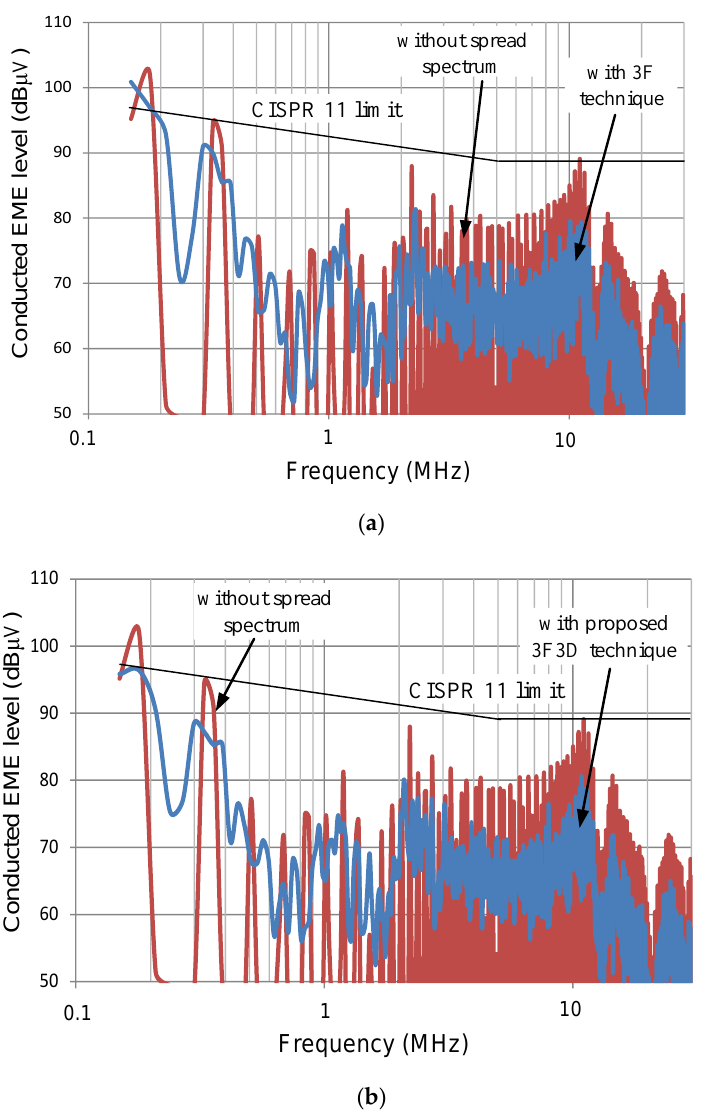
Figure 11. Comparison of spectra of the conducted EME (0.15–30 MHz) from the WPT system without the spread spectrum and with the spread spectrum based on 3-frequency technique ( a ) and based on the proposed 3F3D spread spectrum technique ( b ). Note: other parameters are the same as those in Figure 10.